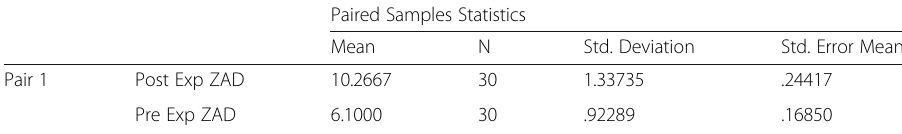
Table 5 Descriptive Statistics of the Experimental group ’ s ZAD performance Paired Samples Statistics